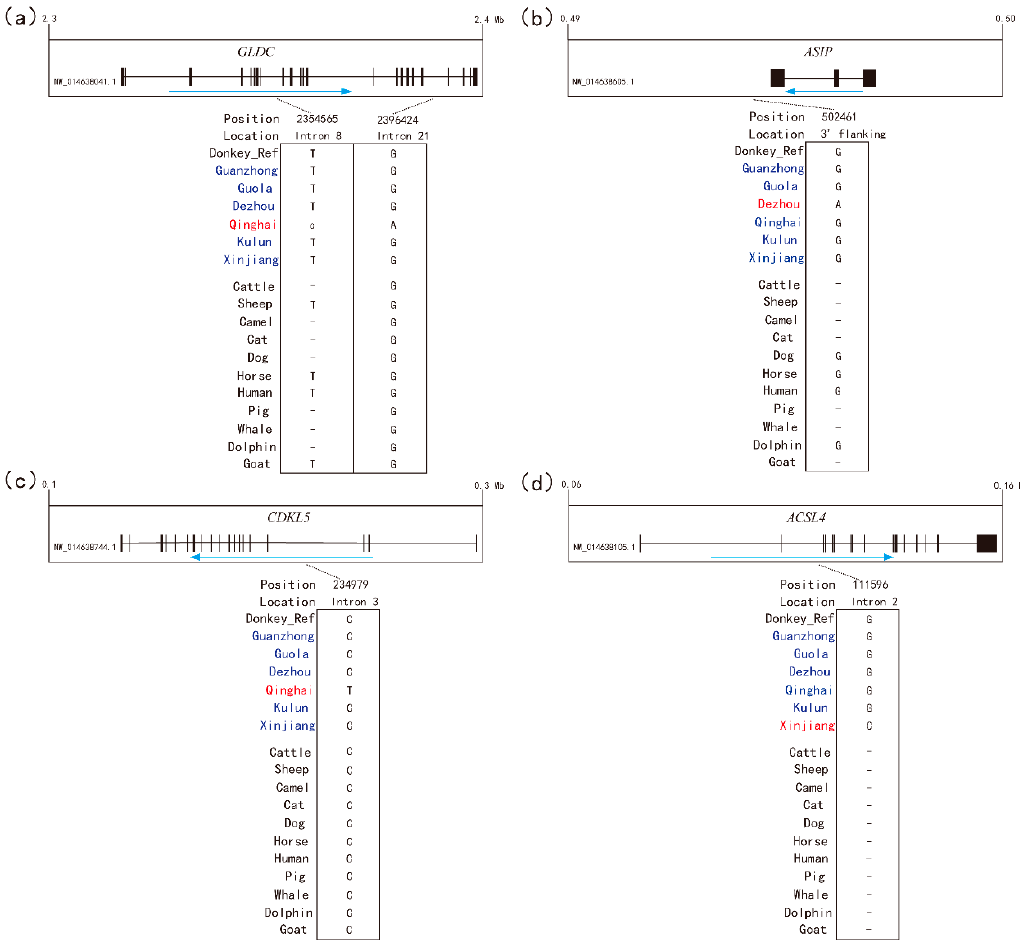
Table S1: Pooled sample information for resequencing data from donkeys. Donkey DNA pools represent six separate breeds. The number of individuals from each breed (n) and the average sequence and assembly coverage per pool are indicated. Table S2: The number of candidate regions and genes identified by ZHp and di in di ff erent breeds. Figure S1: The number of synonymous and non-synonymous mutations in each donkey breed. DZ: Dezhou; GL: Guola; GZ: Guanzhong; KL: Kulun; QH: Qinghai; and XJ: Xinjiang. Figure S2: The number of SNVs with large e ff ects (premature stop, stop codon to nonstop codon, start codon to non-start codon, and splicing sites) in each donkey breed. DZ: Dezhou; GL: Guola; GZ: Guanzhong; KL: Kulun; QH: Qinghai; and XJ: Xinjiang.